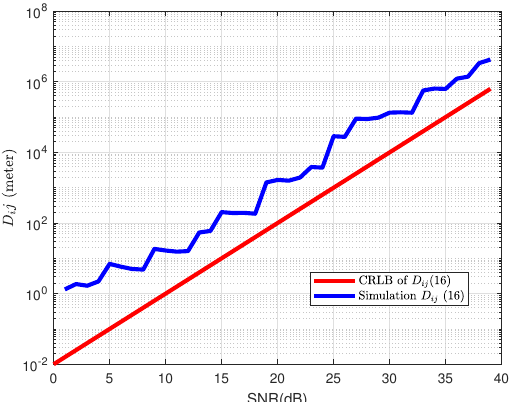
Figure 6. Cramer Rao Lower Bound compared to simulation